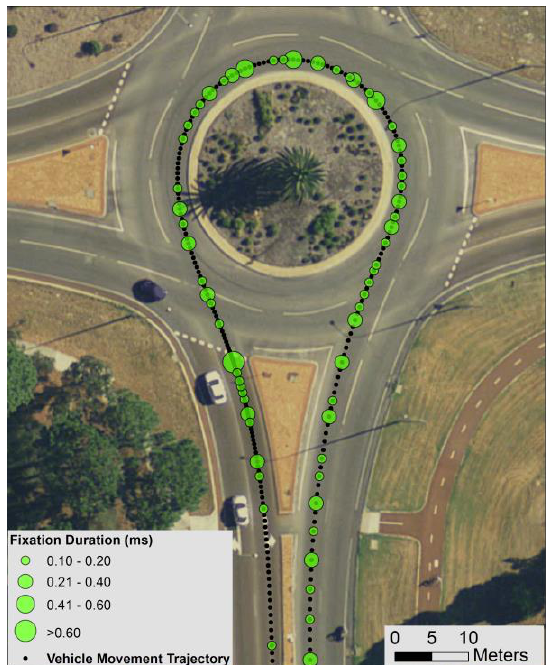
Figure 5. The spatial distribution of eye fixation behaviour at right-turn by driver